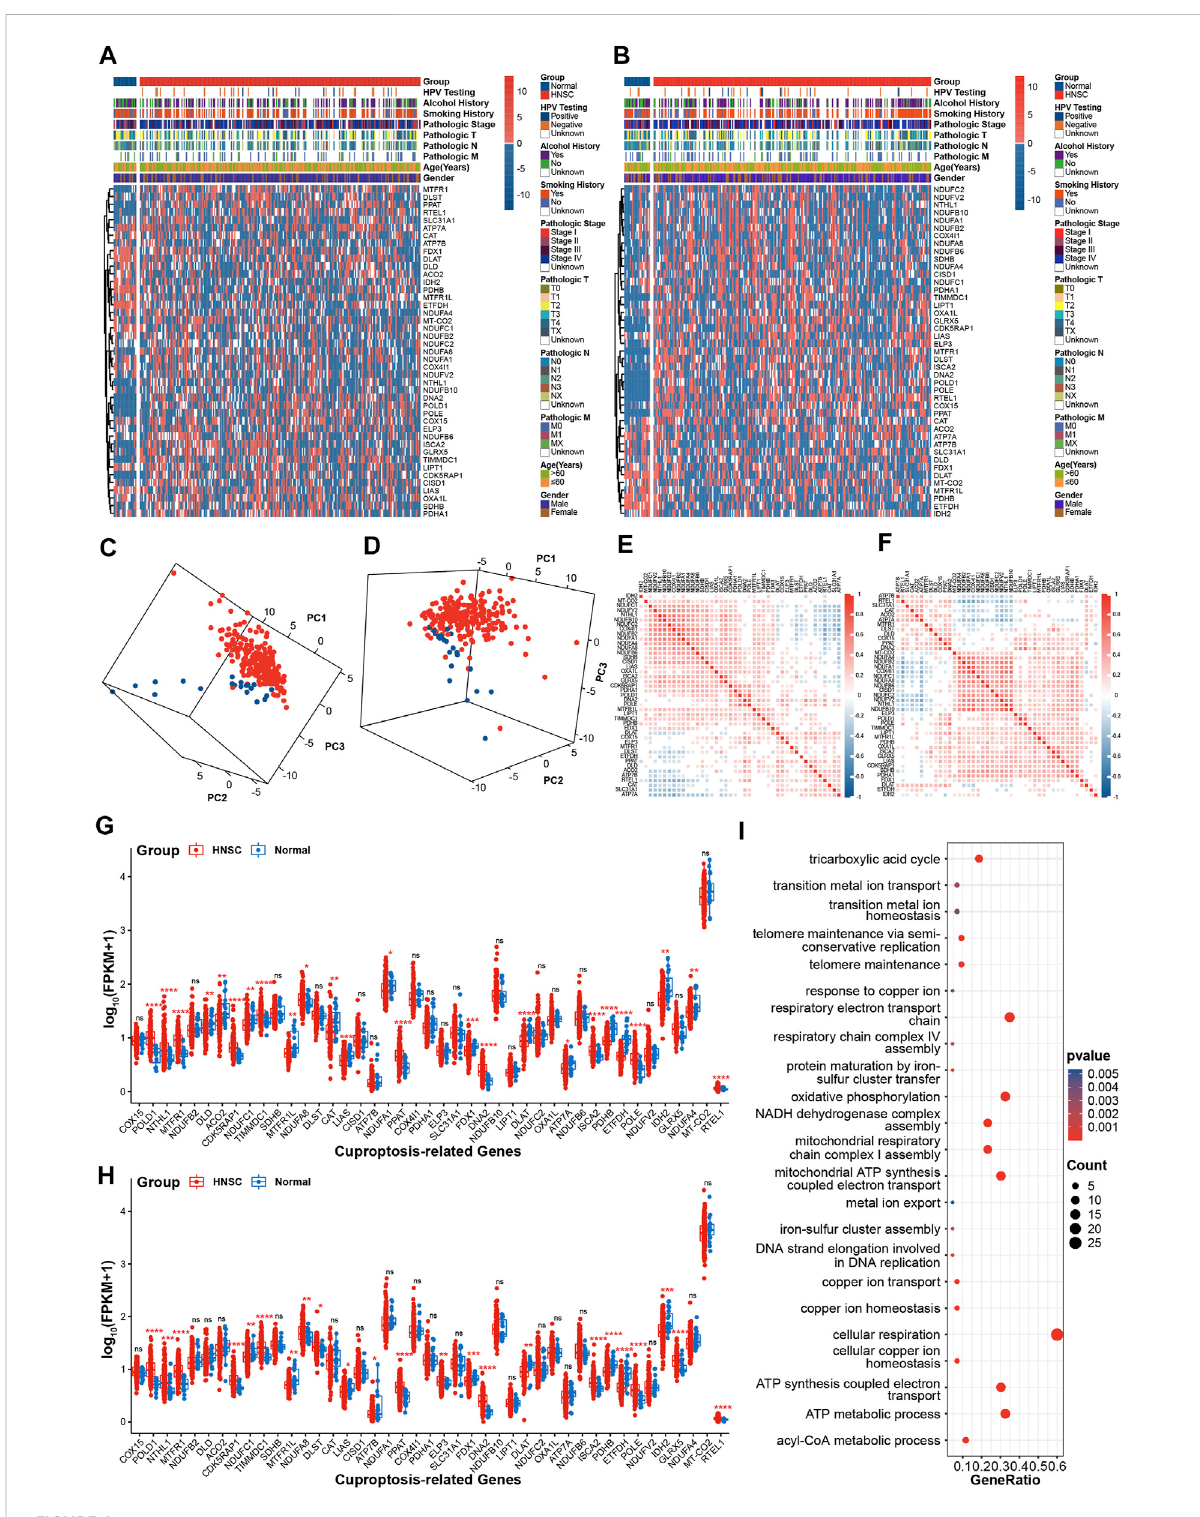
FIGURE 1 Expression patternsofCRGsinHNSC (A , B) The heatmapofCRGs inTCGA- fi rst (A) andTCGA-second (B) cohort (C , D) 3DPCAplots ofCRGsin TCGA- fi rst (C) and TCGA-second (D) cohorts, red: HNSC tissues; blue: normal tissues (E,F) The correlations analysis of CRGs in TCGA- fi rst (E) and TCGA-second (F) cohorts (G – H) BoxplotshowingofCRGsexpressioninTCGA- fi rst (G) andTCGA-second (H) cohorts (I) EnrichmentanalysisofGO biological process terms. *p-value < 0.05; **p-value < 0.01; ** *p-value < 0.001; ****p-value <